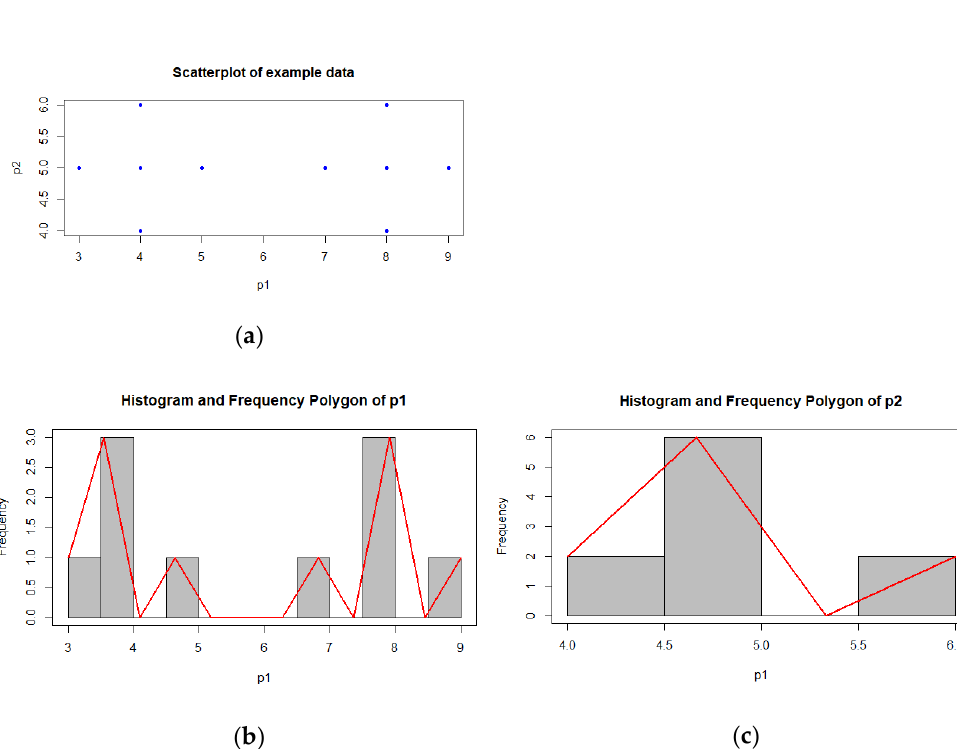
Figure 1. ( a ) Scatter plot for the features p1 and p2 in the example data ( b ) Histogram and frequency polygon of the feature p1 ( c ) Histogram and frequency polygon of the feature p2. For finding the peaks and obtaining the values of peaks to be used as the initial centroids, we have developed the findpolypeaks algorithm (Algorithm 1). The input arguments of this algorithm are the frequencies and middle values of the classes of frequency polygon of the analyzed feature ( xc and xm respectively), a threshold counts value ( tc ) for filtering purposes. The output returned by the algorithm is a peaks matrix PM . At the beginning of the findpolypeaks, the frequencies and middle values of the frequency polygon are filtered and the frequencies below a threshold value, tc are removed from xc. The default value of tc is 1 that means that all 0’s and 1’s are removed from xc because they are not needed or might be noises (Line 1 in Algorithm 1). In this way, the valleys and possible noises in the frequency vector of frequency polygons are eliminated from xc and xm for making the process faster and more robust. Then, the number of classes in xc is computed ( nc ) and an index for the peaks ( pidx ) is started at 1. Algorithm 1 findpolypeaks Input: xc, vector for the frequencies of classes (or bins) of a frequency polygon xm , vector for the middle values of classes (or bins) of a frequency polygon tc , threshold frequency value for filtering frequency polygon data, default value is 1 Output : PM : Peaks matrix for a feature Init : 1: xc xc [ xc >= tc ]; xm xm [ xc >= tc ] //Filter xm and xc for the class frequencies >= tc 2: pfreqs {} //Atomic vector for the frequencies of peaks 3: pvalues {} // Atomic vector for the values of peaks 4: nc length of xc // Number of classes (or number of bins) 5: pidx 1 //Index of the first peak Run: 6: IF nc > 1 THEN 7: